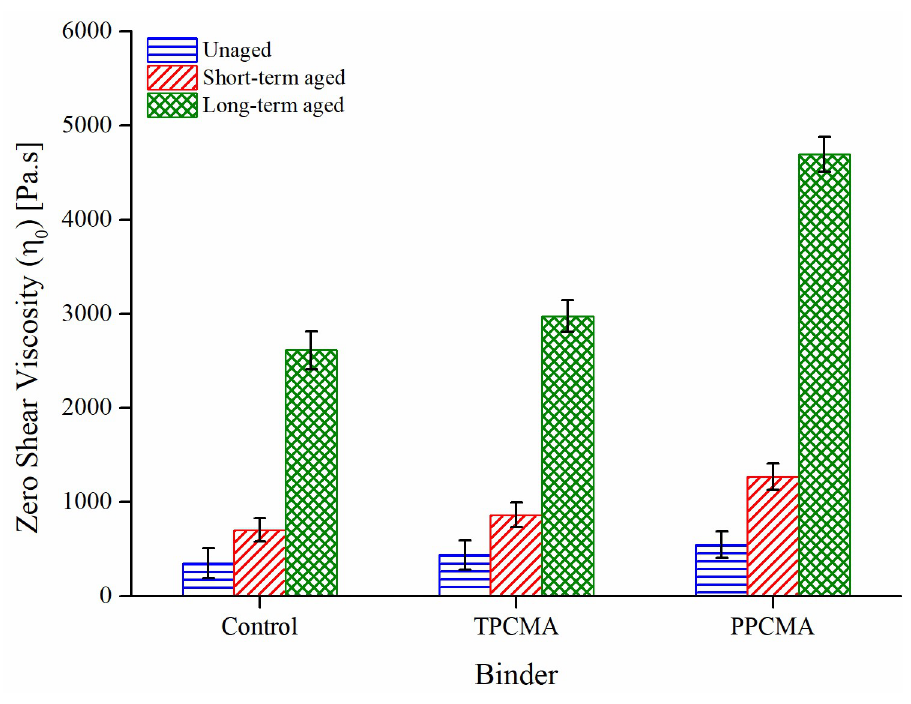
Fig 7. ZSV results at